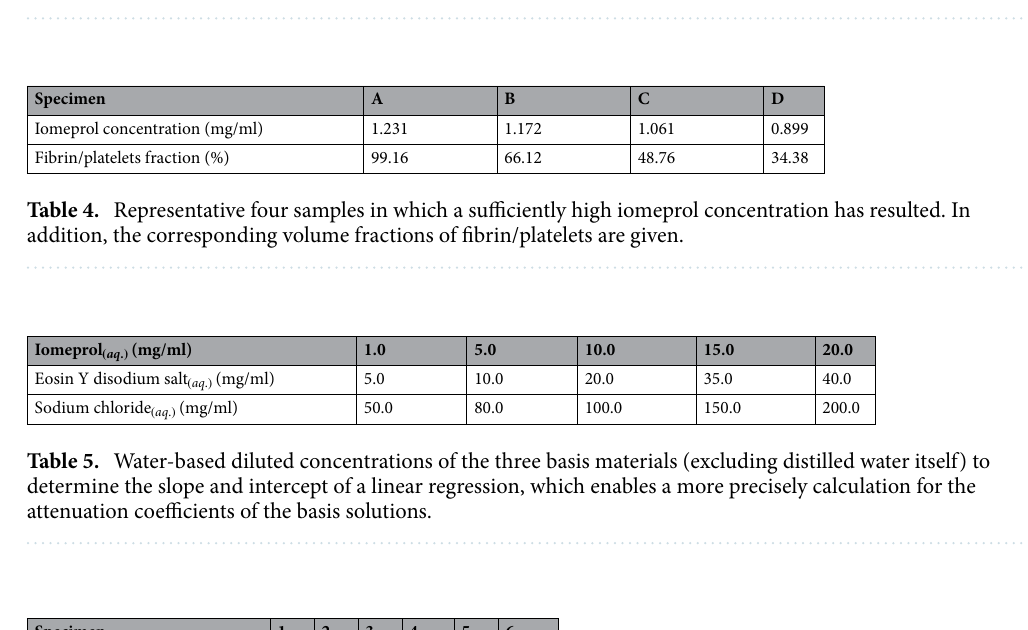
Table 3. Listing the mean of all iomeprol concentrations except the clots used for the optimization for the basis materials and the mean matching errors for these clots separated in the 50keV and 200keV part.